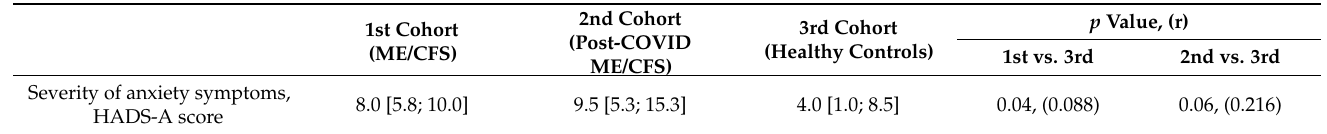
Table 5. Medians of the severity of anxiety symptoms in the cohorts according to HADS-A subscale scores, r—effect size.